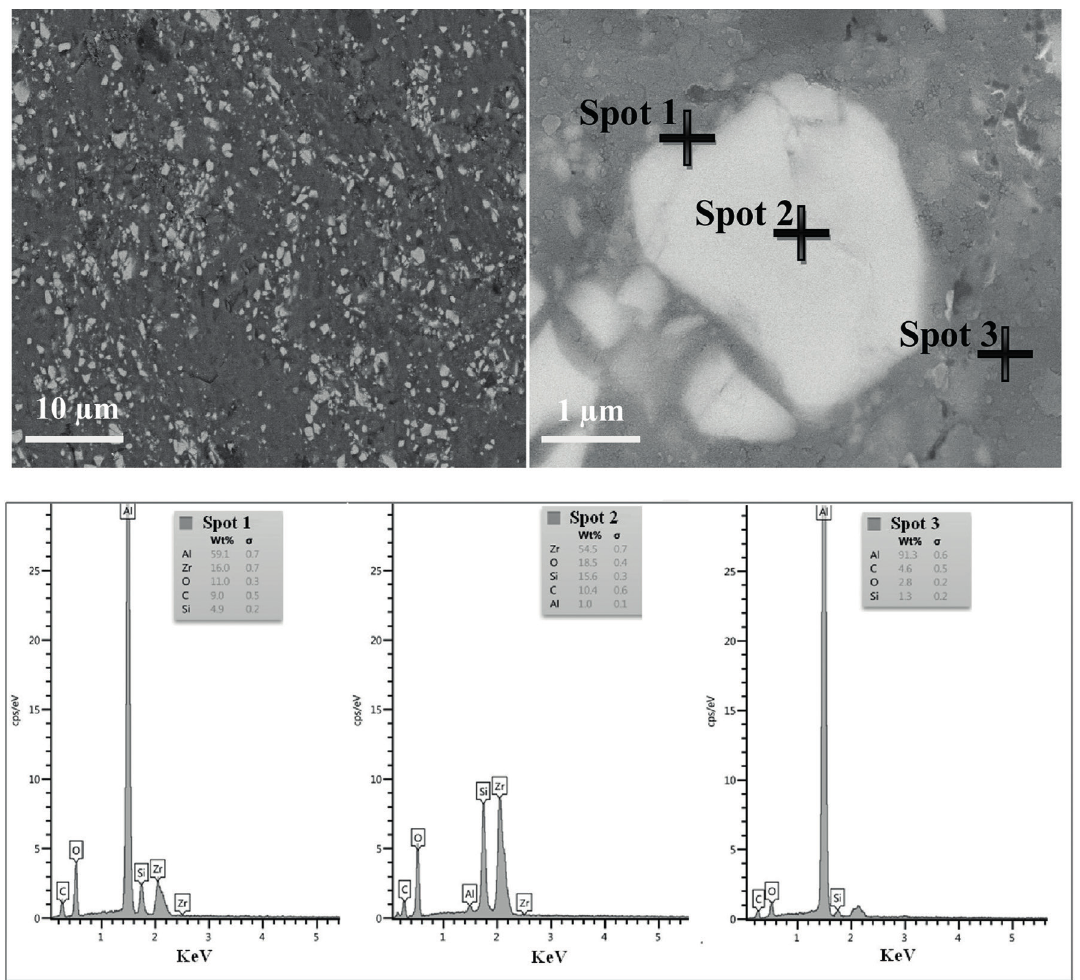
Figure 4: SEM images and EDS spectra of aluminum-zircon